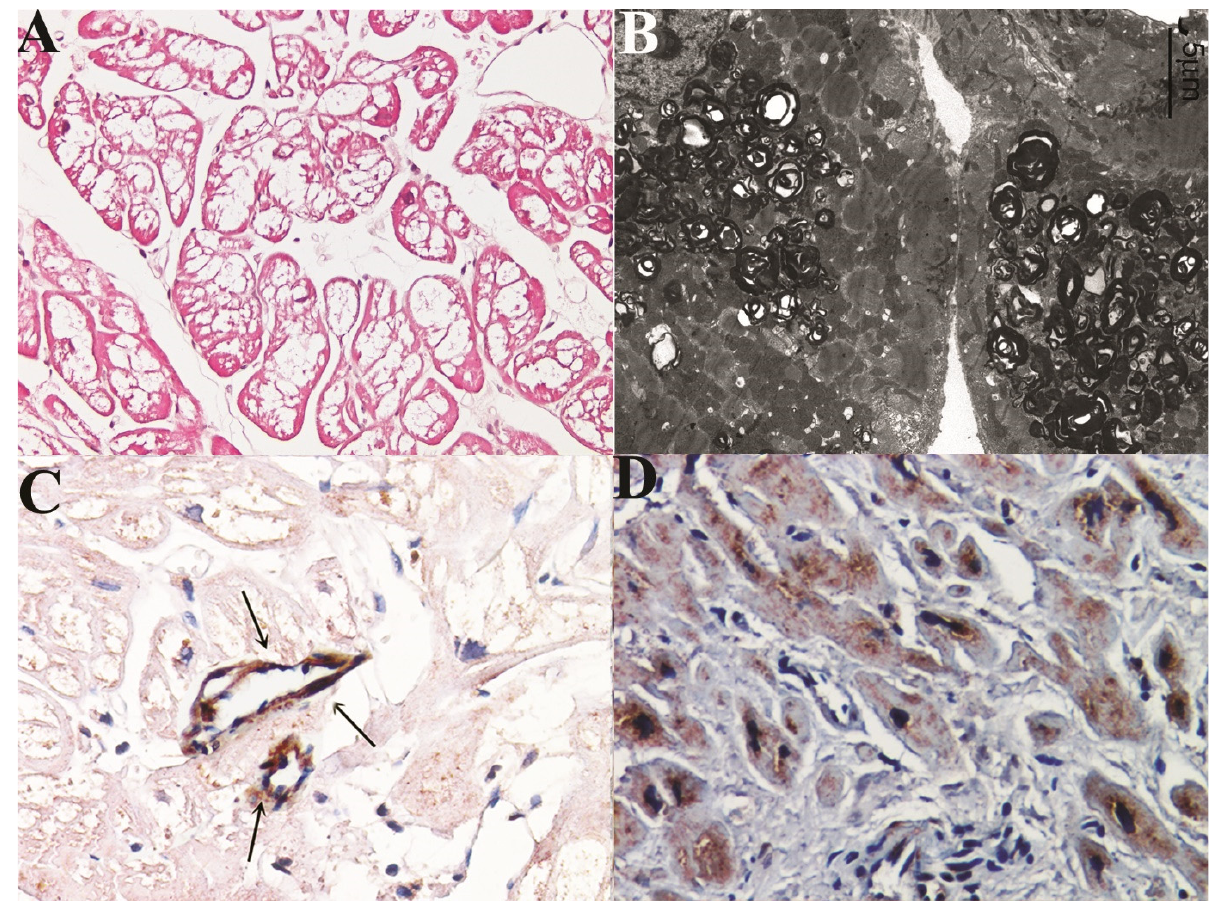
Figure 1. Histology ( A ), electronmicroscopy ( B ) and immunohistochemistry ( C ) for M6Pr in a 43-year-old man (pt 1) affected by Fabry disease cardiomyopathy (MWT 14 mm). In panel ( C ), normal immunostaining of endothelial cells, (black arrows) in contrast with reduced staining of cardiomy- ocytes, is observed. Panel ( D ) represents immunohistochemistry for M6Pr in normal myocardium. The pictures suggest a severe reduced expression of M6Pr in Fabry cardiomyocytes vs.